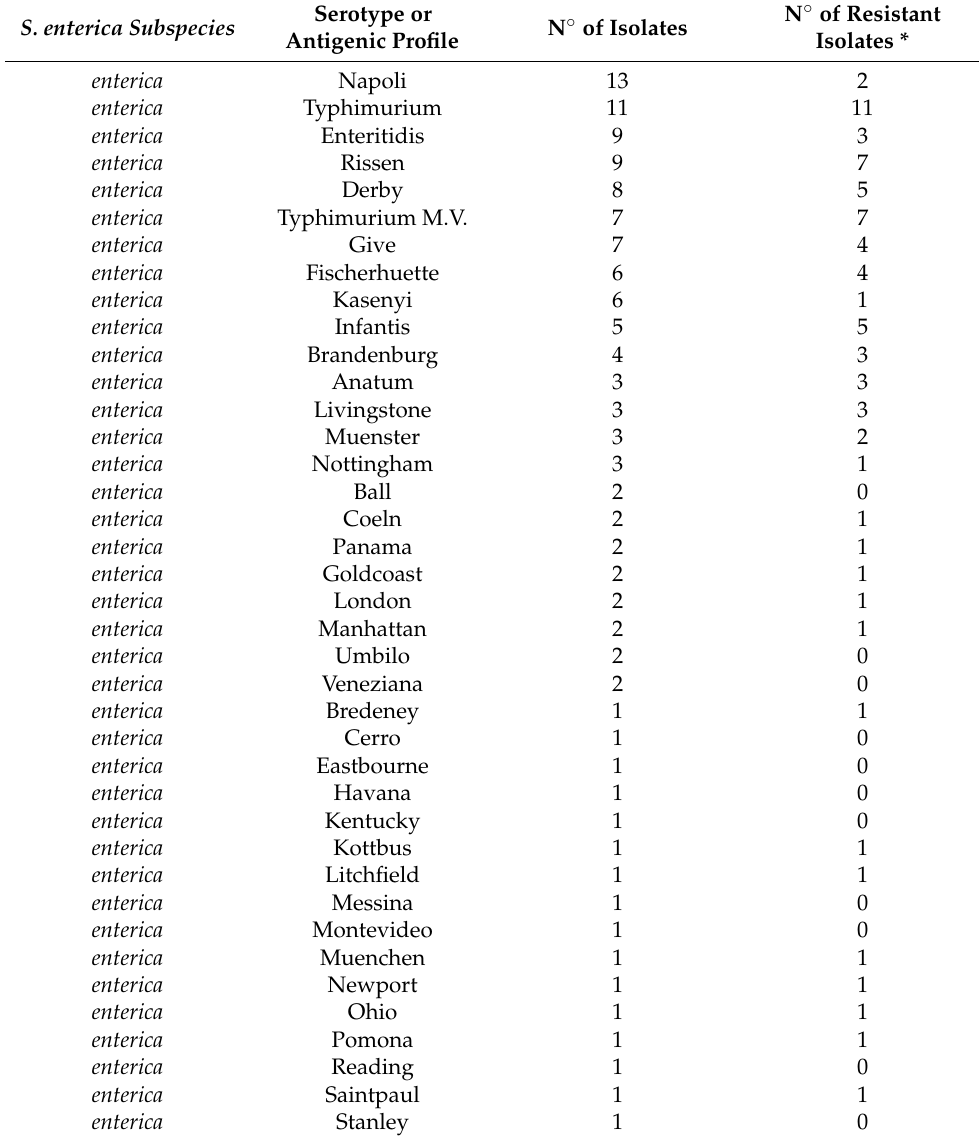
Table 2. Salmonella serovars or antigenic profiles identified within the subspecies enterica, diarizonae , salamae , houtenae , S . arizonae and indica isolated from wild animals and the environment. Serotype or S. enterica Subspecies